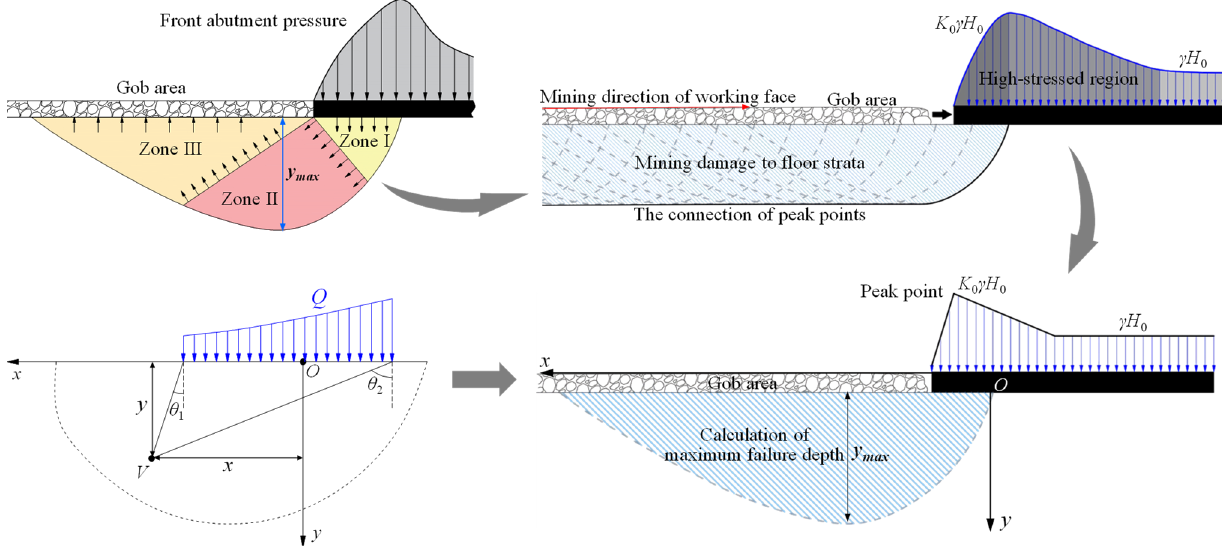
Figure 1. Mechanical model of floor damage caused by mining.